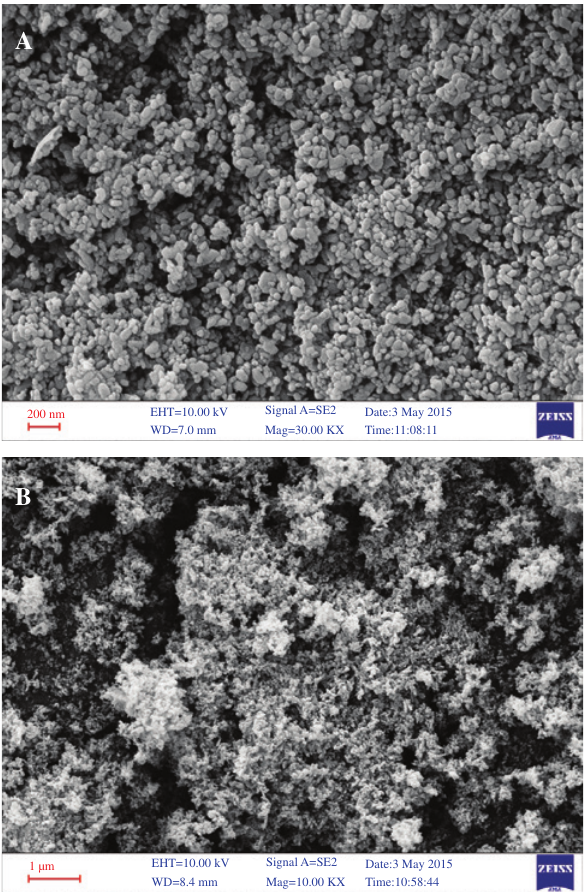
Figure 2: The field emission scanning electronic microscopy (FE-SEM) micrographs of MgO nanostructures.